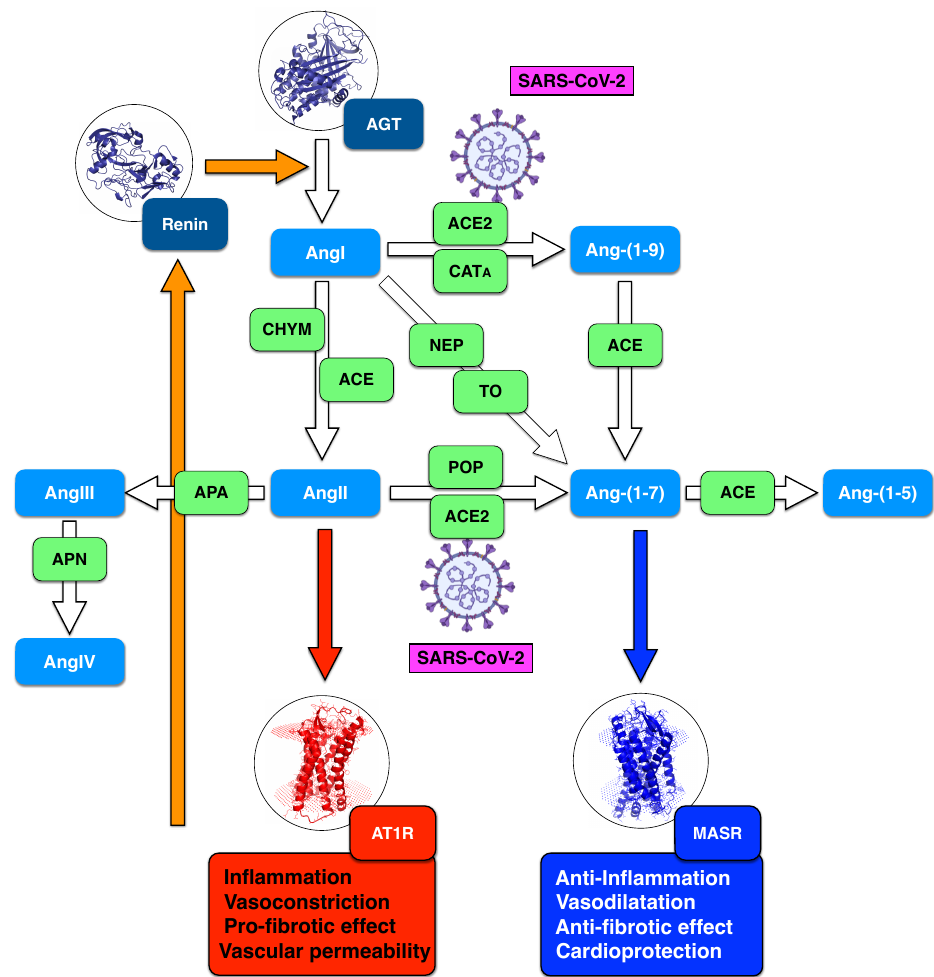
Figure 1. Schematic representation of systemic RAS. The peptides belonging to RAS (AngI, AngII, Ang-(1-5), Ang-(1-7), Ang-(1-9), AngIII, AngIV) are in light blue boxes; renin produced by juxta- glomerular kidney cells and angiotensinogen produced by the liver are in dark blue boxes; the enzymatic actors of RAS are in green boxes: angiotensin converting enzyme (ACE), angiotensin converting enzyme 2 (ACE2), neprilysin (NEP), chymase (CHYM), cathepsin A (CAT A ), thimet oligopeptidase (TO), aminopeptidase A (APA), aminopeptidase N (APN) and prolyloligopeptidase (POP). AngII type 1 receptor (AT1R) is in a red box, with the classical AngII/AT1R axis indicated with a red arrow; the MAS receptor (MASR) is in a deep blue box with the counter-regulatory axis Ang-(1-7)/MASR indicated with a deep blue arrow. The RAS feedback loop is shown with orange arrows. SARS-CoV-2, which acts on ACE2 through the binding of its spike protein, is indicated in